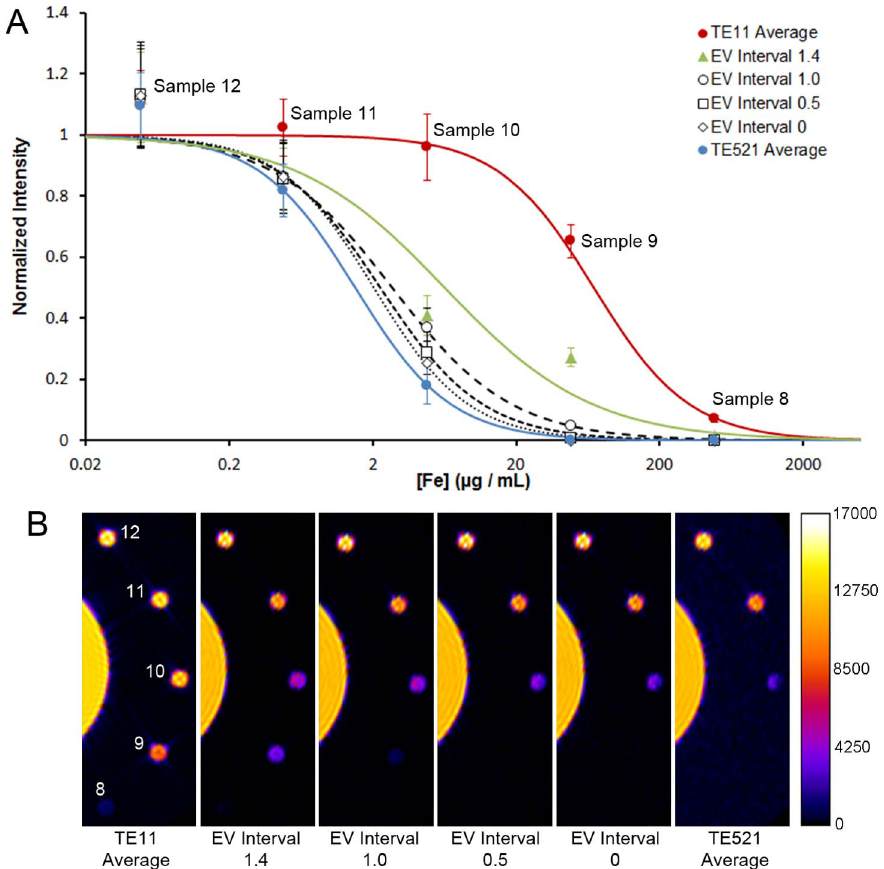
Figure 6. EV interval analysis. (A) Signal intensities normalized against water at various NF concentrations. Sigmoidal curves illustrate trends in the data and can be thought of as characteristic curves. As the EV interval increased, the characteristic curve slope flattened to span over a wider dynamic range. The characteristic curves of the two averaged LDR images (T E 11 and T E 521) had the steepest slopes and were analogous to the EV interval 0 condition. (B) Comparison between averaged LDR images and HDR images. The HDR image with EV interval 1.4 showed contrast between every sample from 8 to 12, indicating its large dynamic range. N=4 was used for the averaged images. Error bars represent standard deviation.